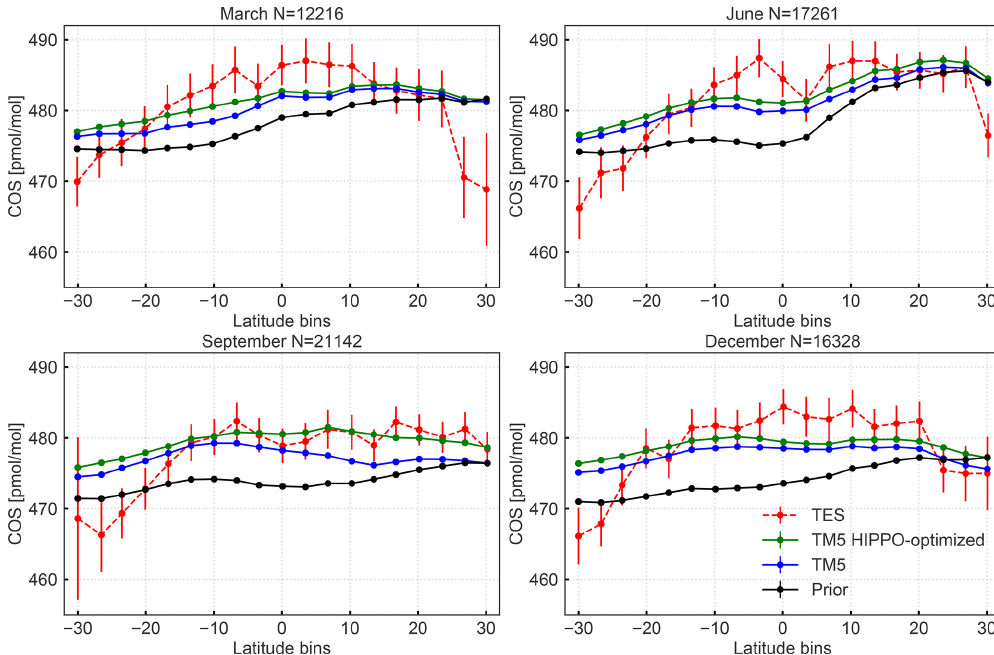
Figure 12. Column-averaged COS mole fractions sampled by TES (red), model prior (black), model posterior (blue) and posterior with HIPPO observations assimilated (green) for March, June, September and December. The columns are averaged over 2008–2010 in 20 lati- tudinal bins from 32 ◦ S to 32 ◦ N. The result of inversion S1 is shown. Error bars on TES represent variability in the measurements, and the number of observations is given in the caption. Variability is mostly determined by measurement noise. A bias correction of β = 0 . 1 was applied when applying the TES AK in Eq.